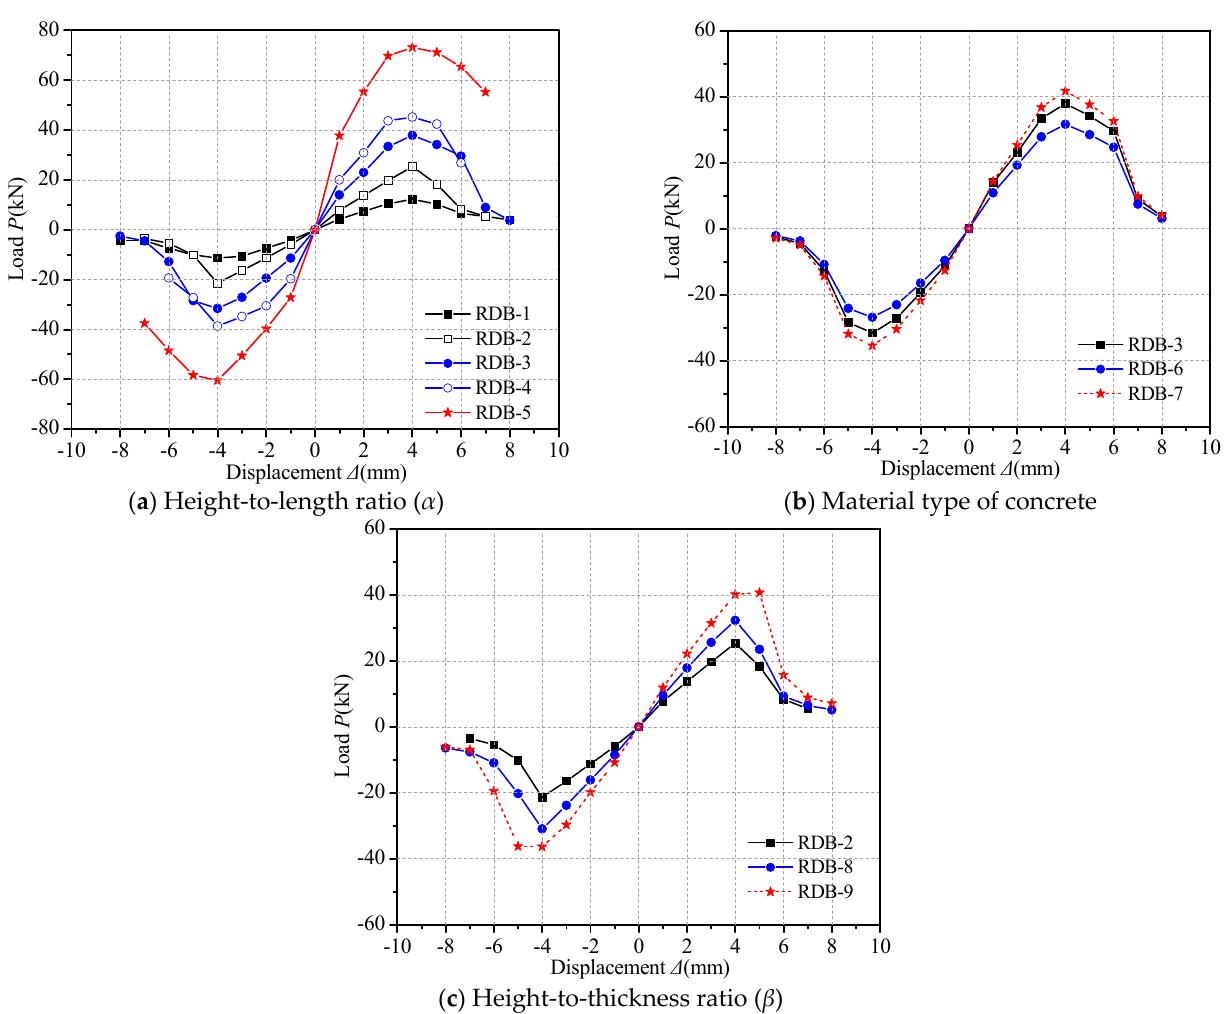
Figure 13. Effects of parameters on seismic performance of RDBs.